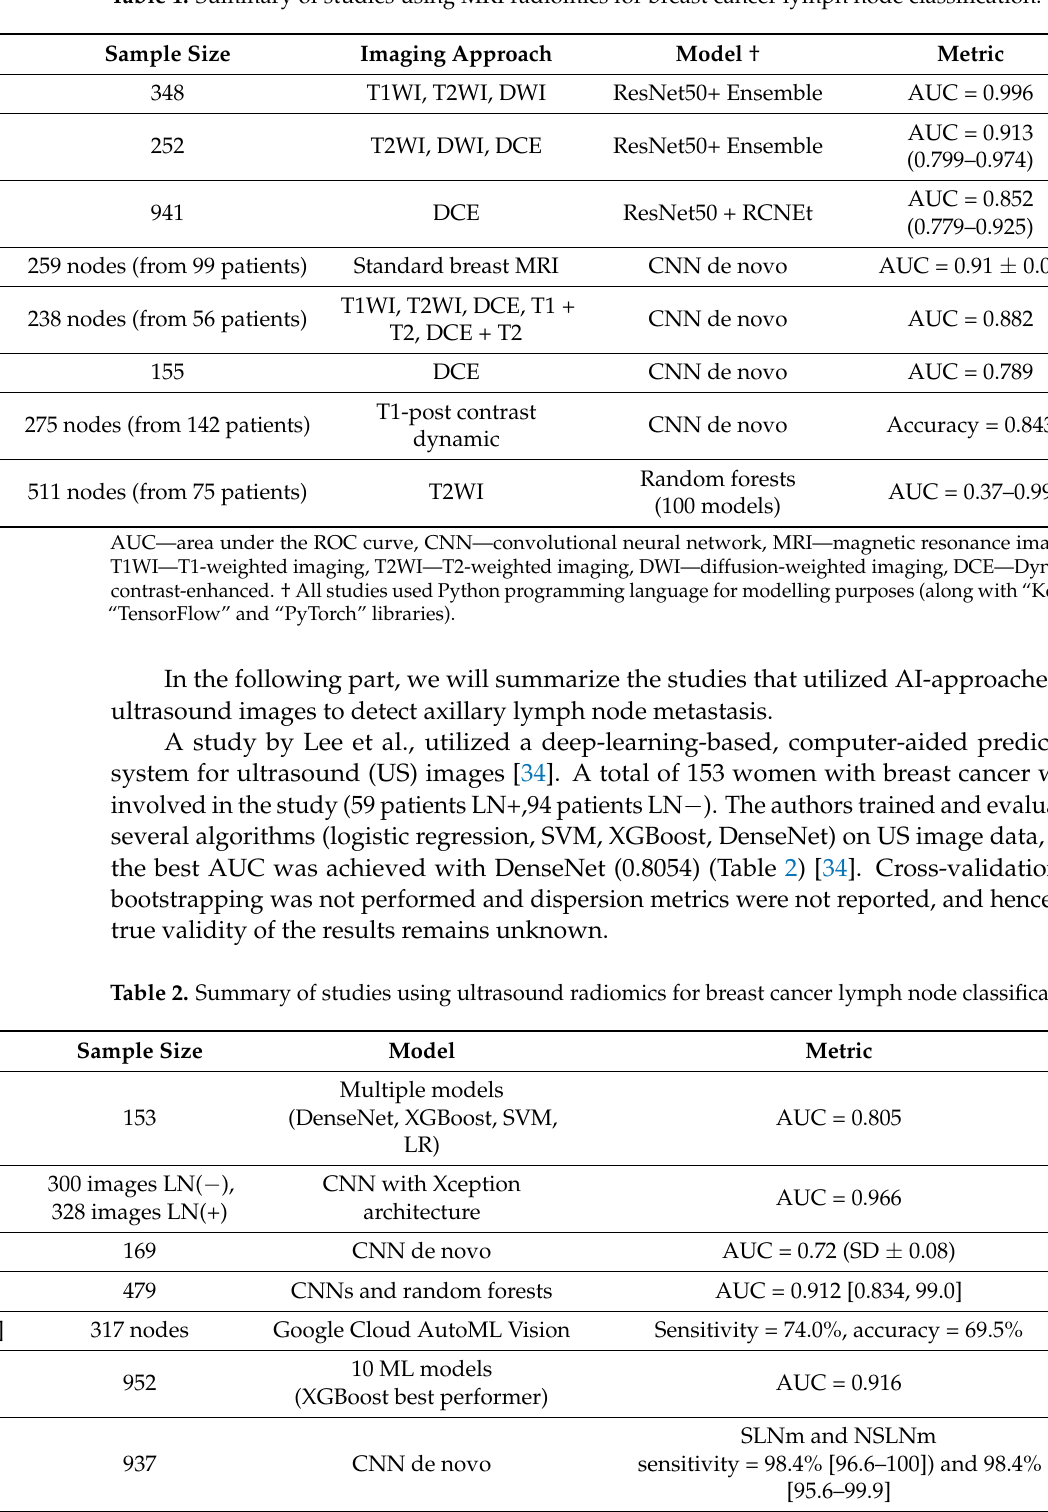
Table 1. Summary of studies using MRI radiomics for breast cancer lymph node classification.